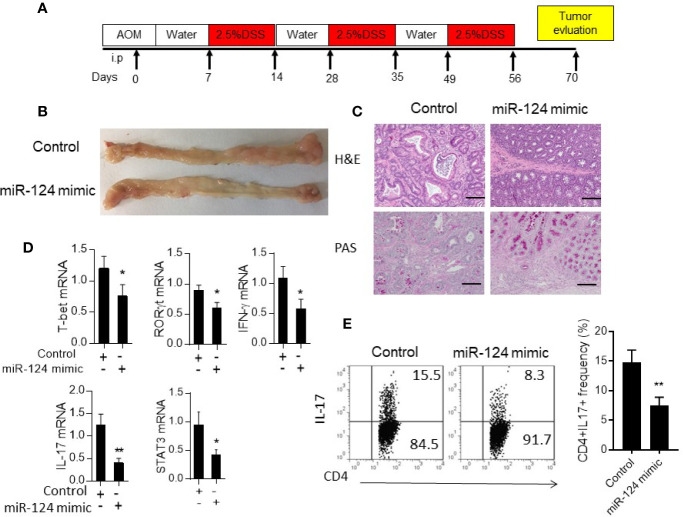
miR-124 suppressed the development of colitis associated carcinoma by inhibiting the TH17 differentiation. (A) Schematic of AOM/DSS administration. Mice were injected with 12.5 mg/kg AOM and subjected to three 7-day cycles of 2.5% DSS respectively in the presence of control or miR-124 mimic. (B, C) Morphology of intestines and representative H&E-stained sections and PAS after DSS or AOM/DSS treatment. Scale bar: 100 μm. (D) Total RNA was extracted and mRNA was detected by qPCR, b-actin as control. *P < 0.05; **P < 0.01. The results are representative of three independent experiments. (E) The percentage of IL-17-producing cells from mesenteric lymph nodes of mice in control and miR-124 mimic treated group. *p < 0.05 versus recipients of control treated group.